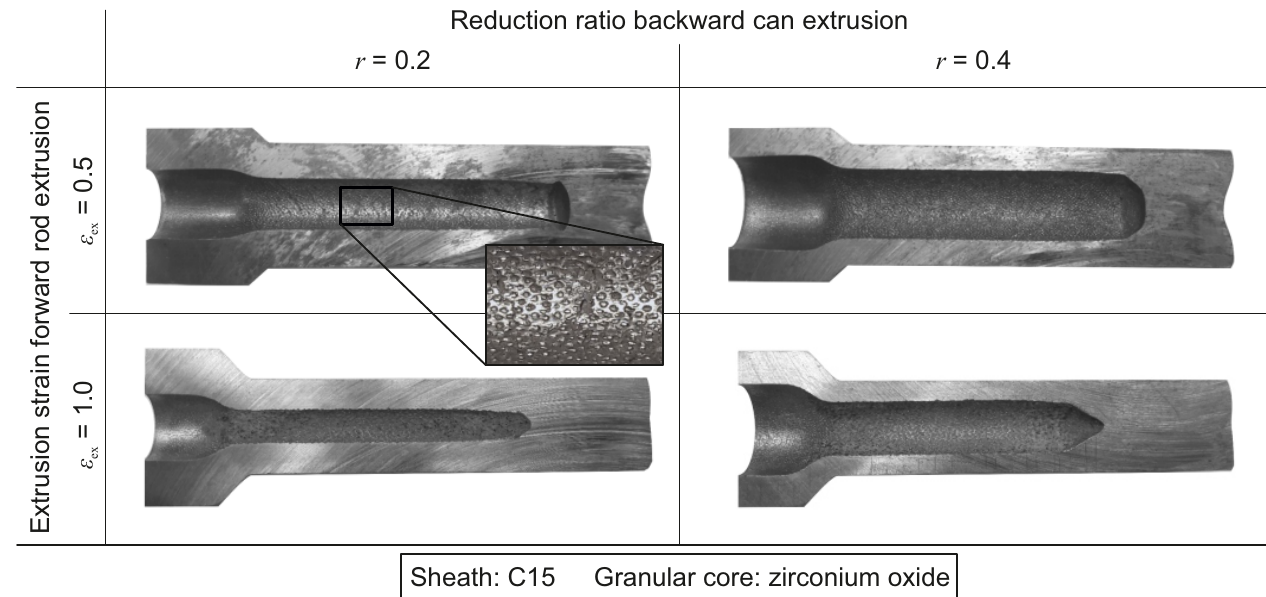
Figure 13. Hollow shafts produced by forward rod extrusion of steel cup billets filled with zirconium oxide, cut open to reveal inner surface.